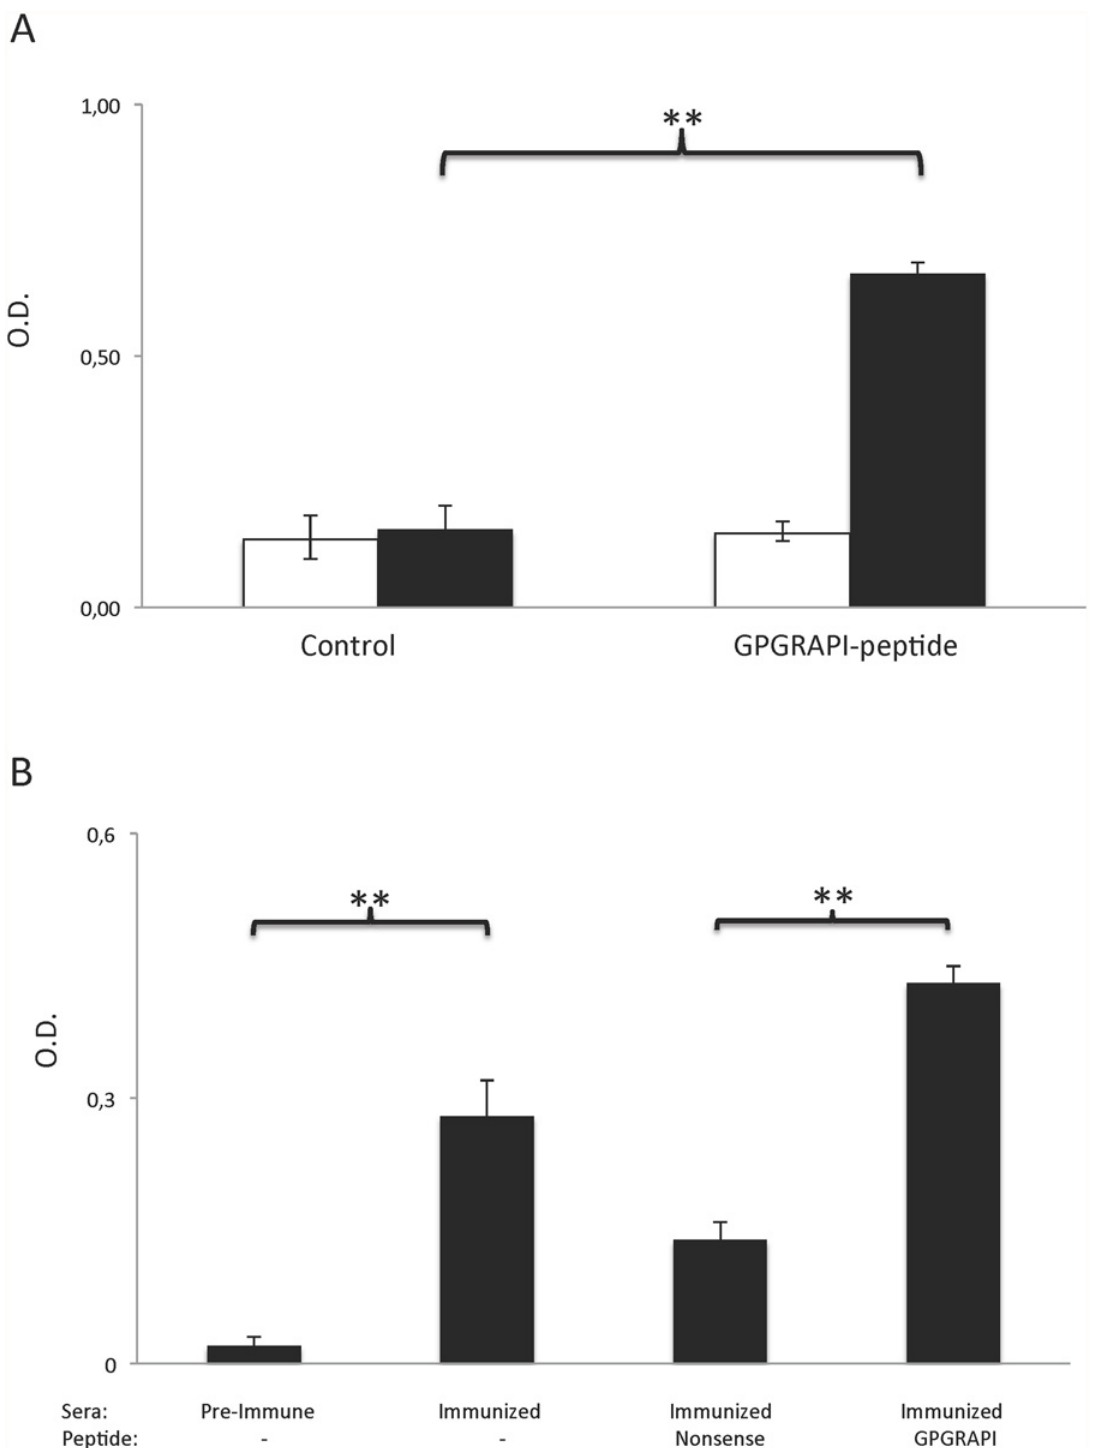
Fig 2. Polyclonal rabbit anti GPGRAPI-GST serum: A) After immunization the polyclonal antiserum but not a control protein (scrambled sequence) strongly binds to immobilized synthetic GPGRAPI. Pre-immune rabbit serum (white column) served as negative control and did not bind to either peptides. B) Binding of the polyclonal antiserum to immobilized GPGRAPI-GST fusion protein is competitively inhibited by synthetic GPGRAPI- but not by the control peptide. Preimmune serum from the same rabbit served as negative control. Error bars represent standard deviation of triplicates, ** indicates p < 0.001